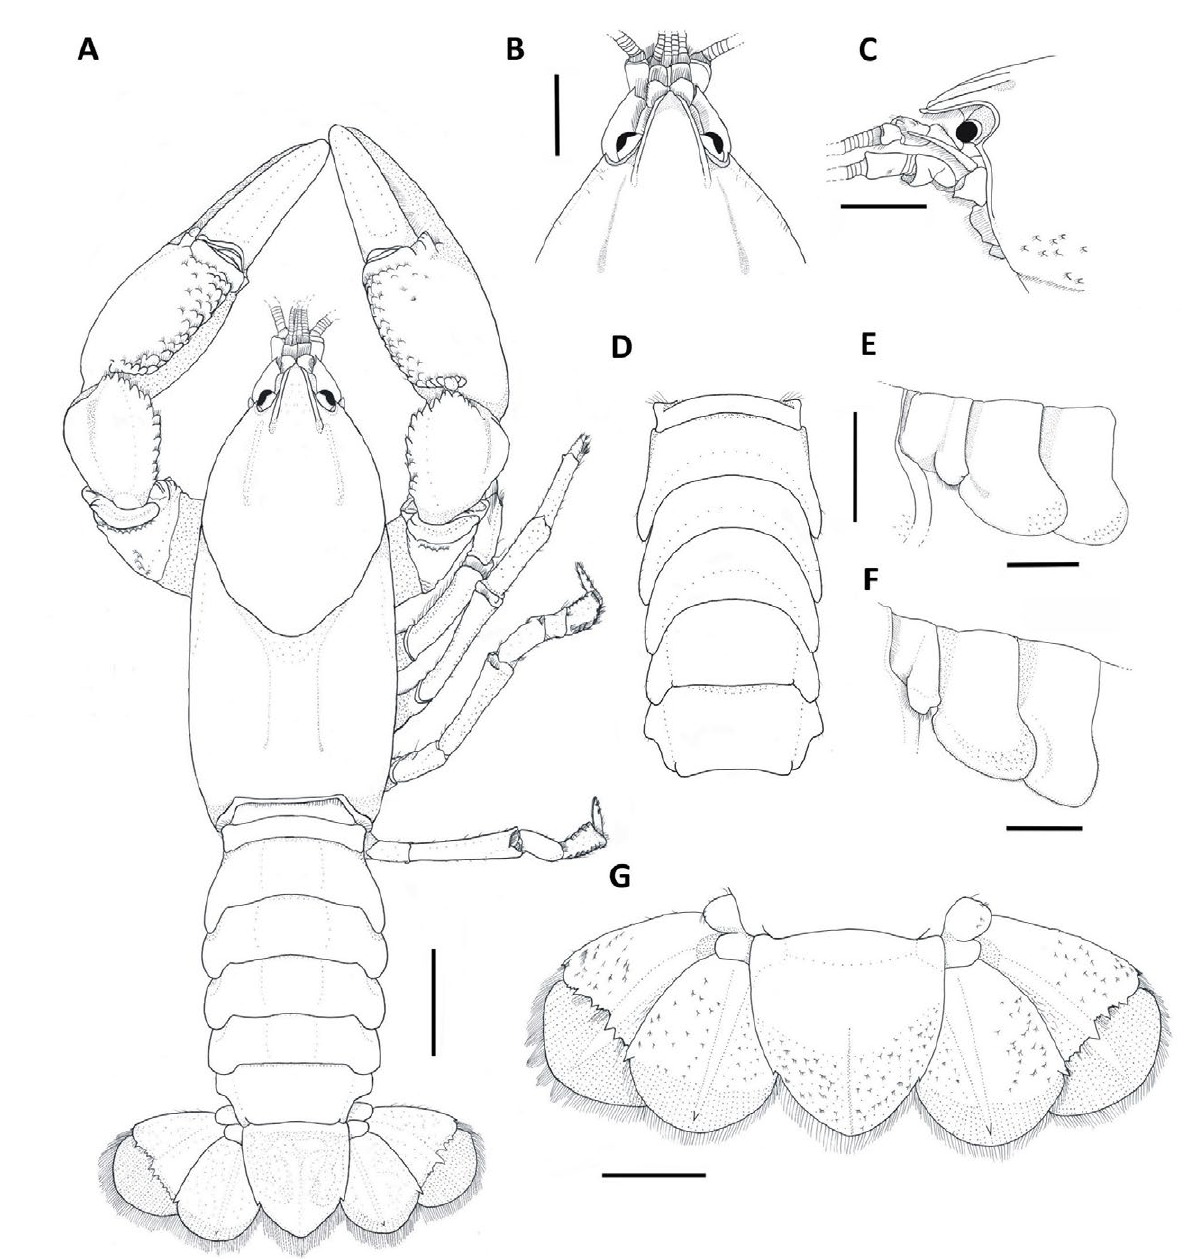
Figure 1. Parastacus buckupi sp. nov. A, habitus dorsal view (holotype); B, cephalon dorsal view (holotype); C, cephalon lateral view (holotype); D, female pleon (paratype 4); E, male first to third pleonal pleura (holotype); F, female first to third pleonal pleura (paratype 4); G, tailfan dorsal view (holotype). Scale bars: A – 1 cm; B–D, G – 5 mm; E, F –